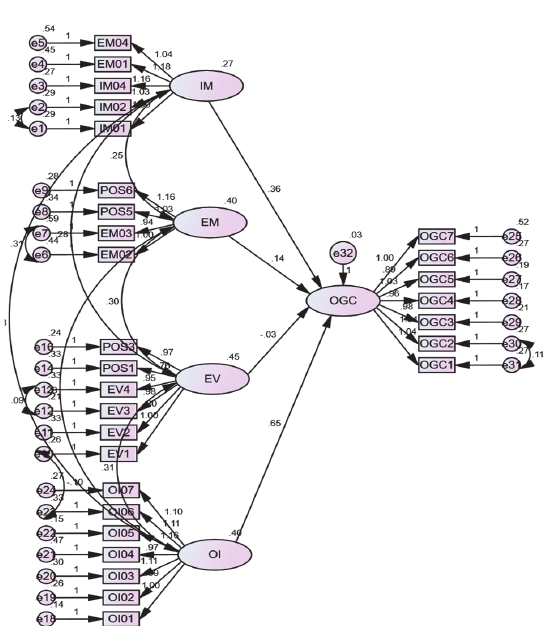
Fig. 1. Results of CFA concepts of research model (standardized) P=.000; CFI = .884; TLI = .870; GFI = .781; RMSEA =